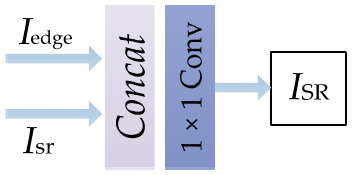
Figure 5. The structure of the Fusion part.